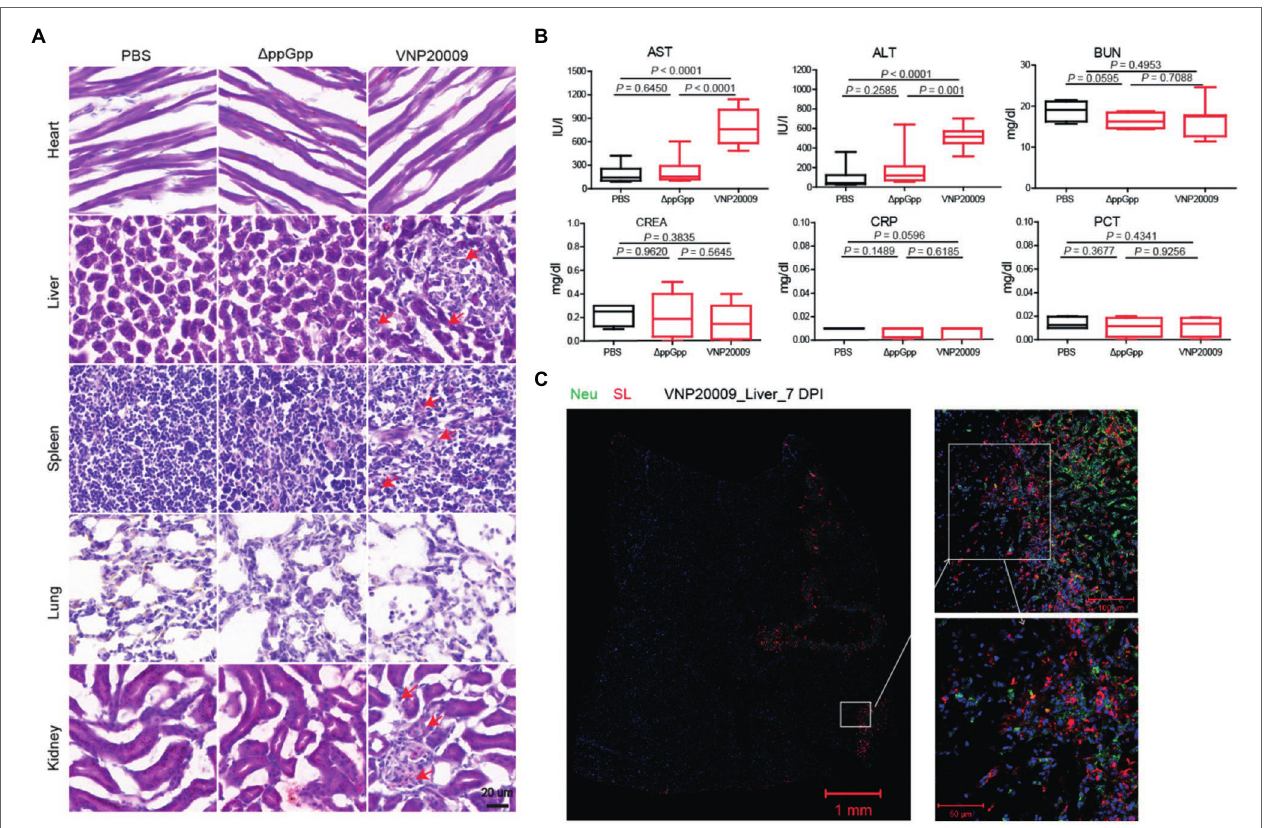
FIGURE 6 | Biosafety studies after Δ ppGpp and VNP20009 treatments. (A) After 7 days of bacterial injection, organs (heart, liver, spleen, lung, and kidney) from treated mice were analyzed by H&E staining. Scale bar = 20 μ m. (B) Measurement of clinical chemical parameters, such as ALT ( p < 0.0001), AST ( p < 0.0001 between PBS and VNP20009 and p = 0.0001 between Δ ppGpp and VNP20009), BUN, CREA, CRP, and PCT, in mouse serum 7 days after bacterial injection ( n = 8). (C) Seven days after bacterial injection, the neutrophils (green) and S. Typhimurium (red) in the liver of VNP20009-injected mice were analyzed by immunofluorescence